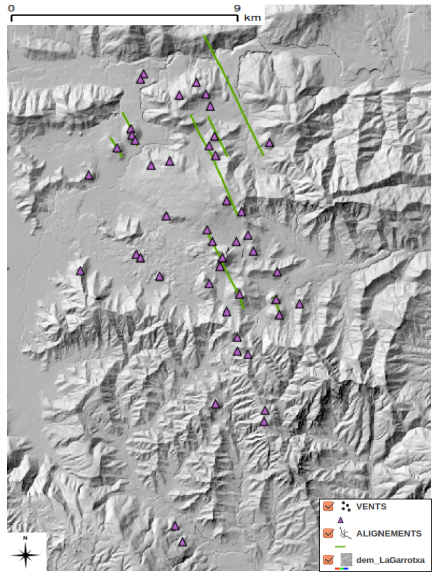
Fig. 6. Main volcano structural data (dykes, vent alignments and emission centers) used to build the susceptibility map of La Gar- rotxa. The topographic base is 25m resolution DEM.